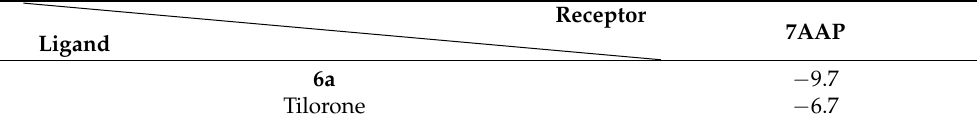
Table 2. Docking score values of compound 6a and reference drug (tilorone) for target protein 7AAP, kcal/mol. Receptor 7AAP Ligand 6a − 9.7 Tilorone −